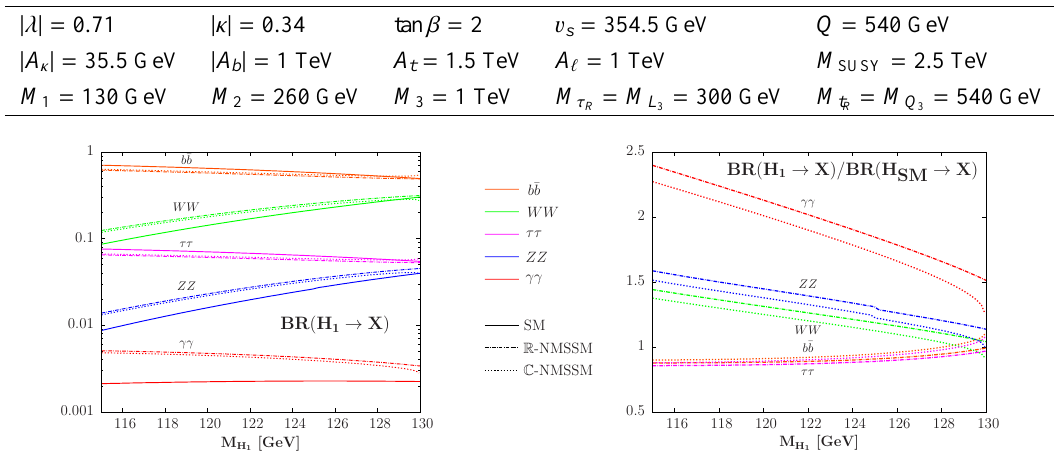
Table 1. The set of parameters used in the study of section 3.